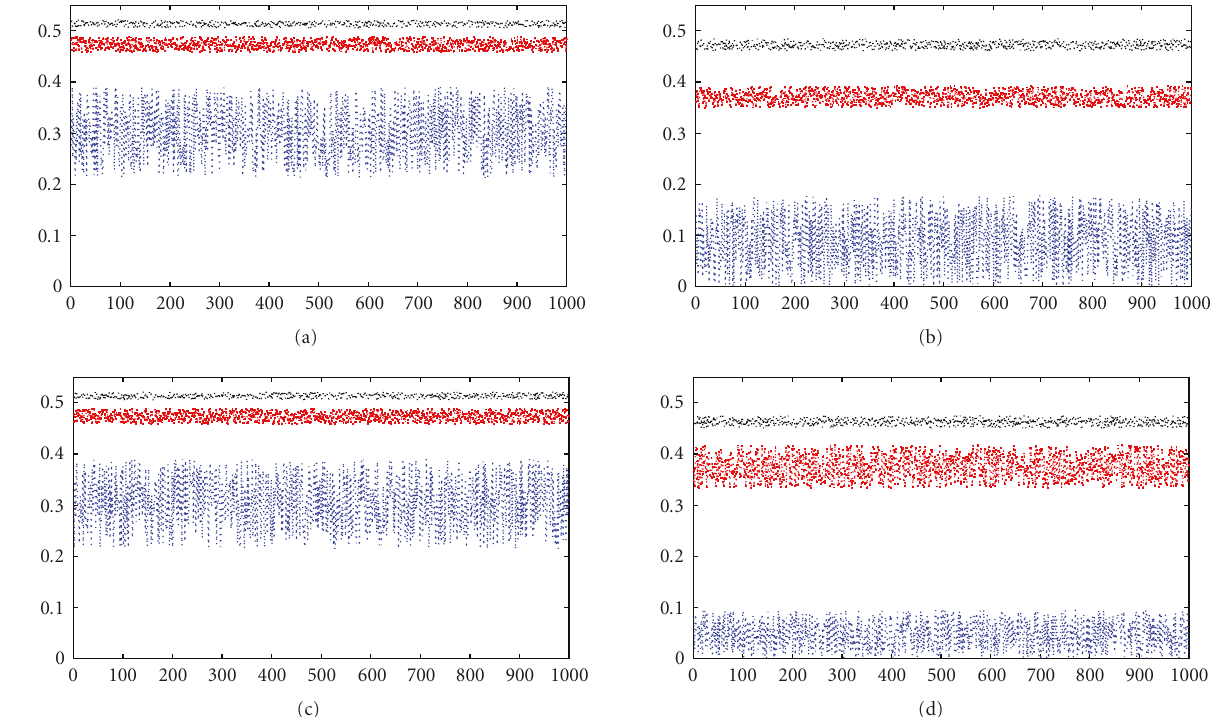
Figure 17: Hamming distance of match (blue, bottom), nearest nonmatch (red, middle), and average nonmatch (black, top) of (a) Daugman [5], (b) Monro et al. [15], (c) Ma et al. [7], and (d) proposed method using Bath iris